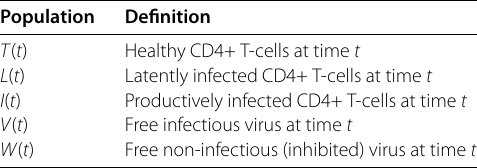
Table 1 Variables in the model (adapted from [1, 5, 6, 15])